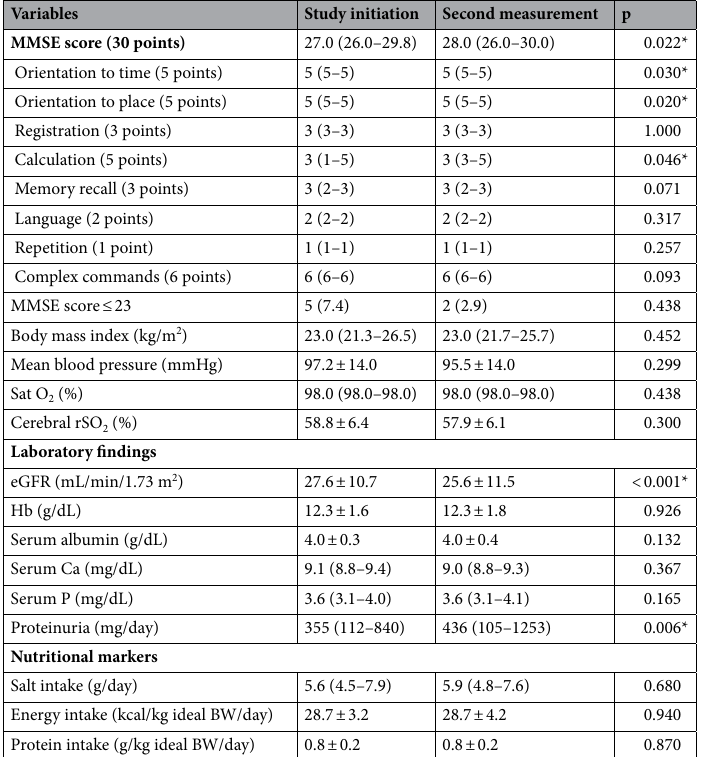
Table 1. Comparison of clinical parameters between the study initiation and second measurements in this study. Categorical data are presented as number (%), continuous data are presented as mean ± standard deviation or median and interquartile range. *Statistically significant. BW body weight, eGFR estimated glomerular filtration rate, Hb haemoglobin, MMSE Mini-Mental State Examination, rSO 2 regional oxygen